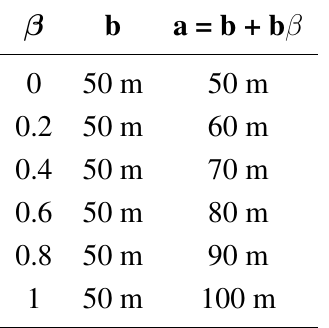
Table 1. Different values of β